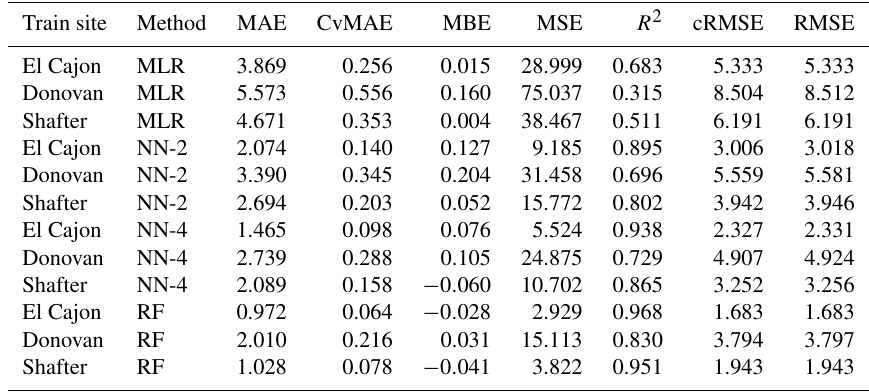
Table C5. Level 1 train results for NO 2 (train and test on the same data